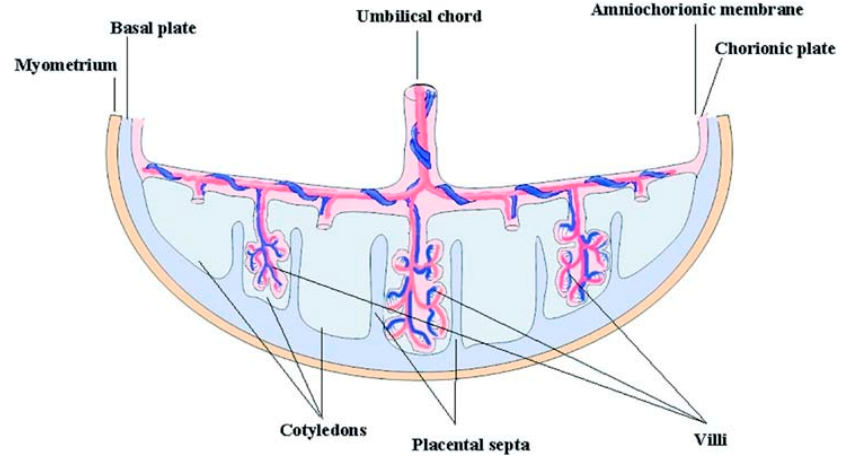
Figure 5. Schematic illustration of the cross-section of human term placenta. All fetal stem cells are isolated from this part of the human fetus. Reproduced with permission from Reference [106]